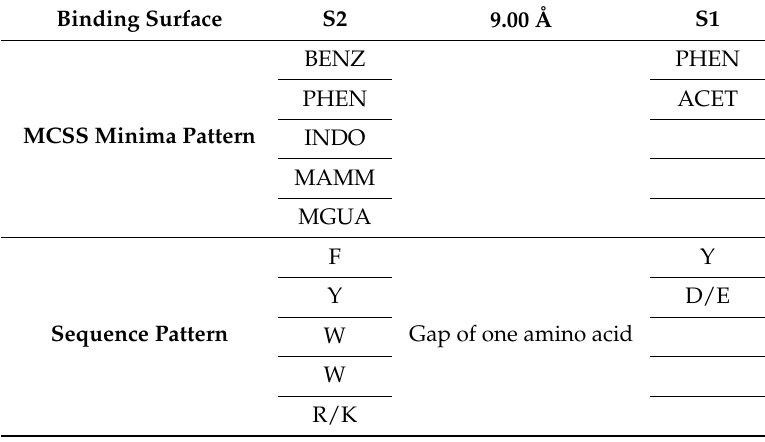
Table 3. Distribution of key minima and the derived sequence pattern for the binding epitope